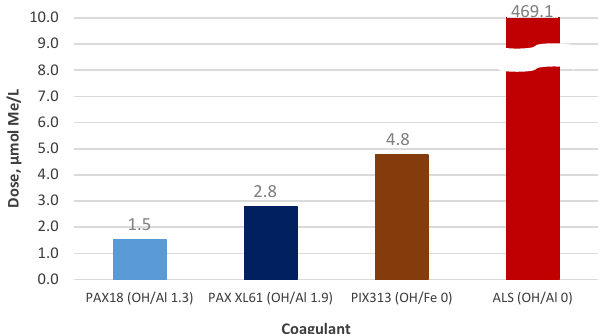
Figure 11. Coagulant dose required for reaching the endpoint during the potentiometric titration of mixed liquor.